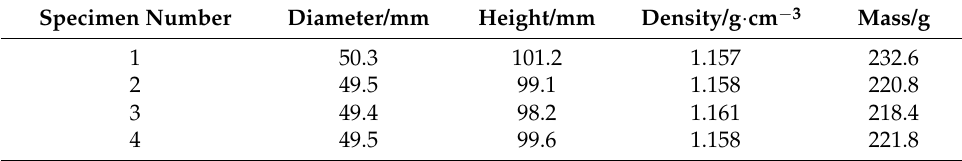
Table 1. The basic parameters of tested coal specimens. Specimen